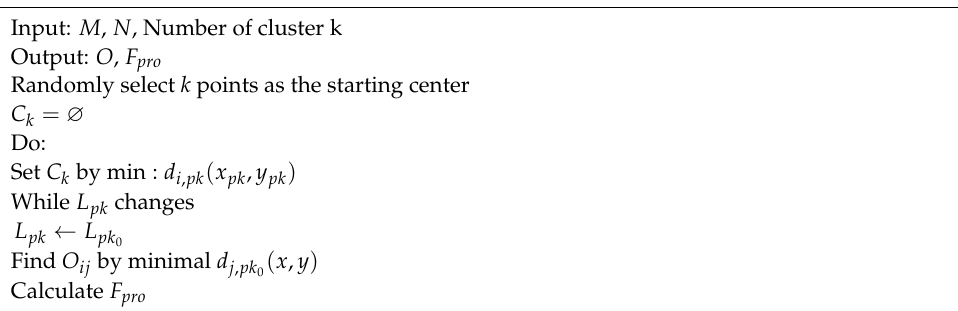
Algorithm 1: k -means for the Placement